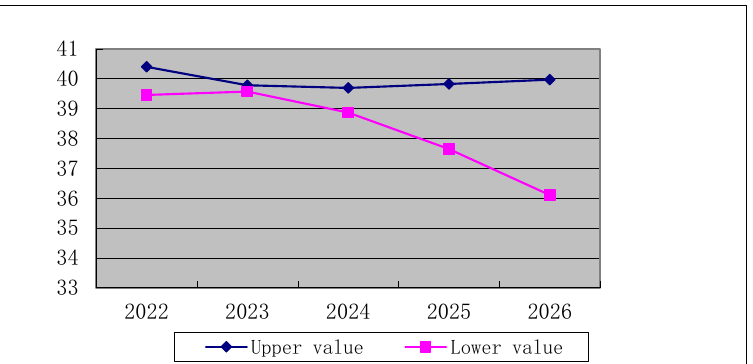
Figure 4. The variation interval of water requirement with the influence of tertiary industry in Beijing.